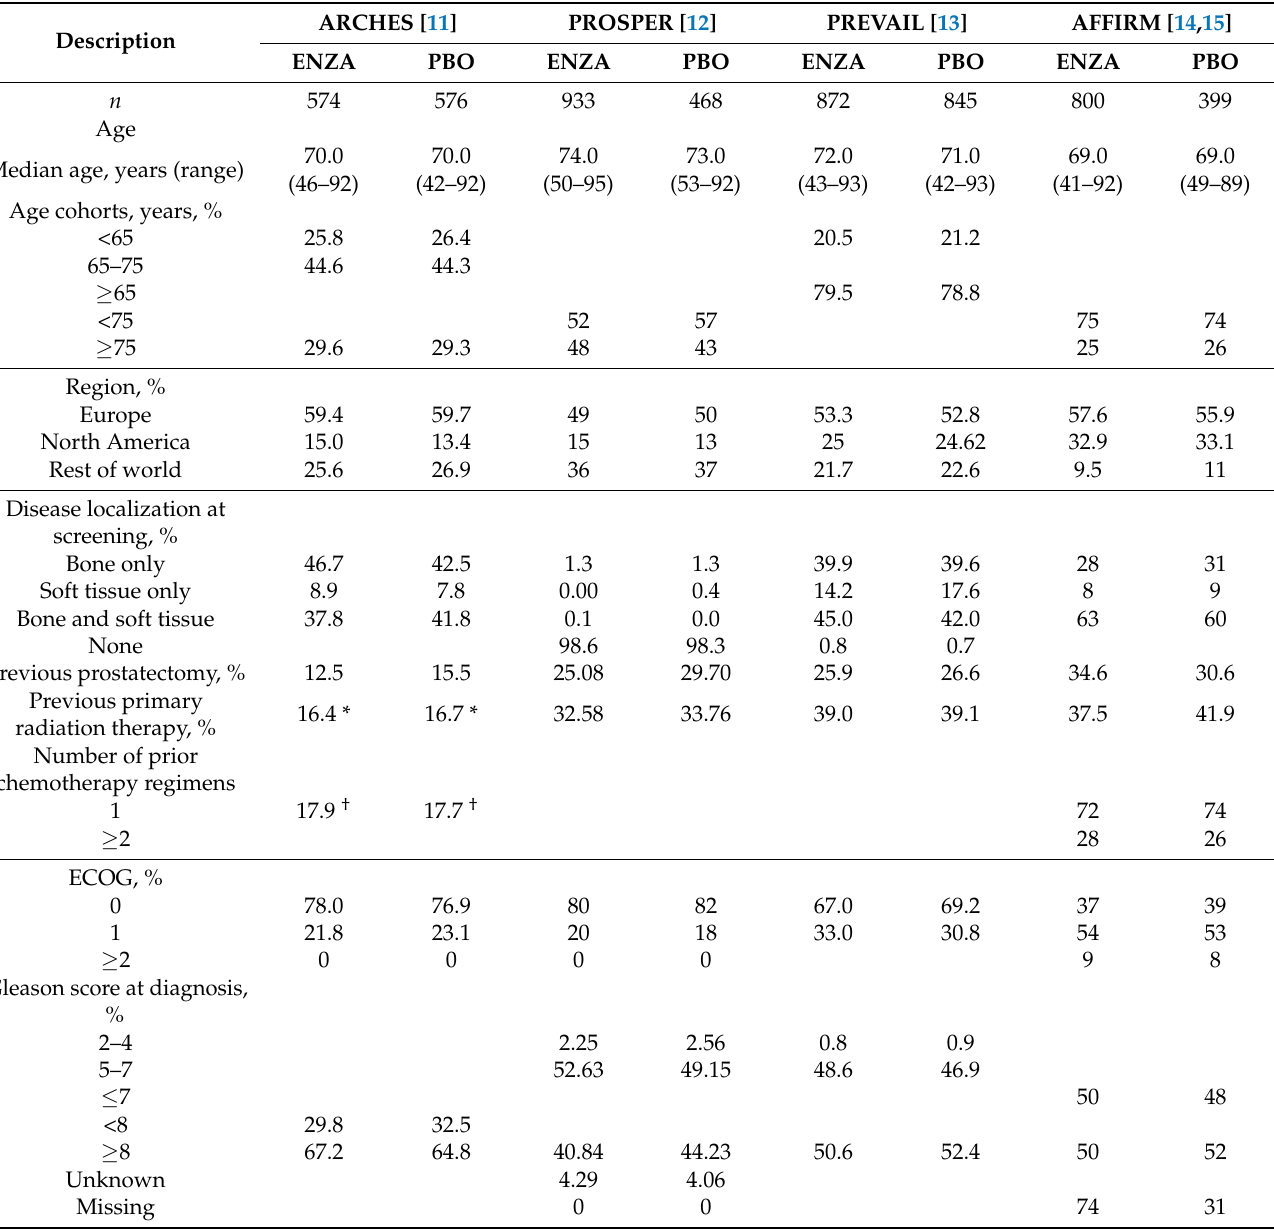
Table 3. Baseline patient